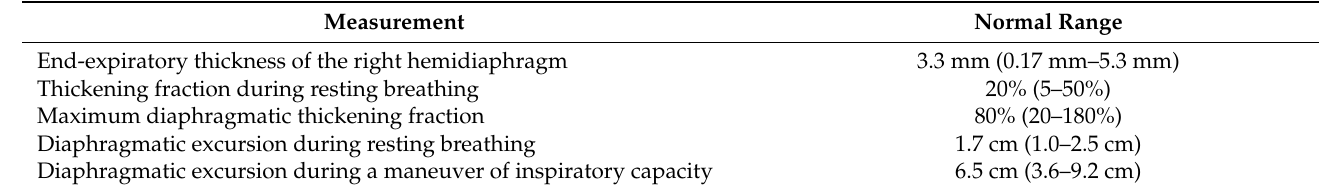
Table 1. Normal reference values of diaphragm ultrasound measurements expressed as medium (5–95 ◦ percentile). Adapted from: Goligher EC. Diaphragm Ultrasound. In: Magder S, Malhotra A, Hibbert KA, Hardin CC (Editors). Cardiopulmonary Monitoring. Basic Physiology, Tools, and Bedside Management for the Critically Ill. Springer Nature Switzerland AG